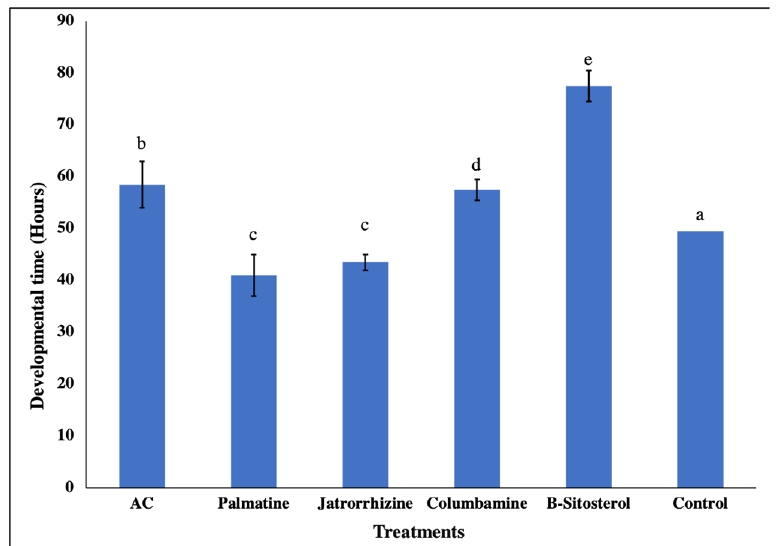
Figure 3. Effect of tested LC 50 concentrations of palmatine, jatrorrhizine, columbamine, β -sitosterol, and Annickia chlorantha extract (AC) on the mean pupal developmental durations (hours) of the mosquito, Culex pipiens . Bars with different letters are significantly ( p < 0.05) different. Data presented as mean ± SE of three replicates.